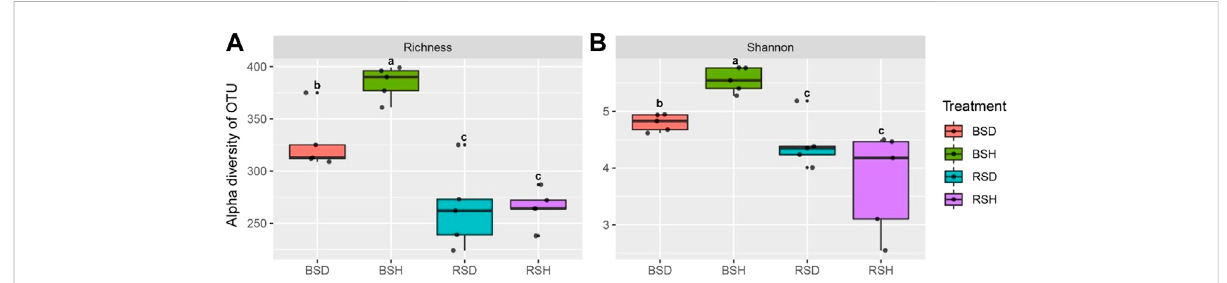
FIGURE 1 Difference analysis of alpha and beta diversity of fungi among the bulk soil of the diseased plant, the bulk soil of healthy plants, the rhizosphere soil of disease plants and the rhizosphere soil of healthy plants. (A) Richness index of BSD, BSH, RSD, and RSH; (B) Shannon index of BSD, BSH, RSD, andRSH;BSD,thebulksoilofthediseasedplant;BSH,thebulksoilofhealthyplants;RSD,therhizospheresoilofdiseaseplants;RSH,therhizosphere soil of healthy plants. Signi fi cance satis fi es p < 0.05 based on Tukey test.